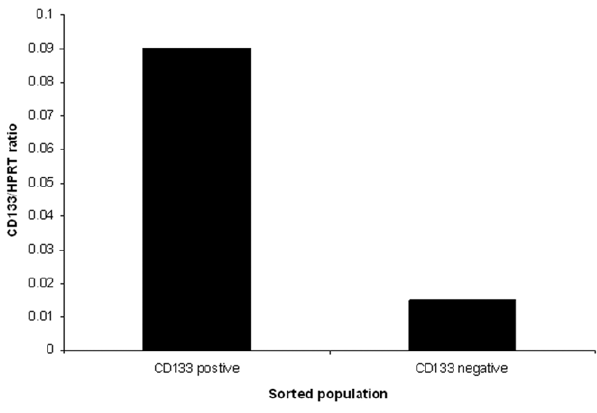
Figure 8. mRNA level in sorted populations. Q-RT-PCR analysis of the sorted populations showed that there was transcriptional repression of CD133 in the CD133 2 population (although low levels of mRNA were still